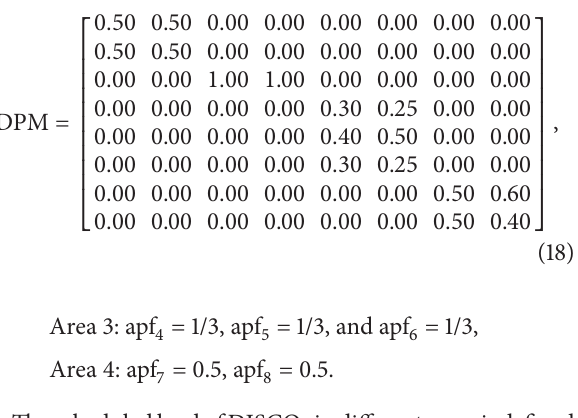
Table 4: The optimized parameters of PID